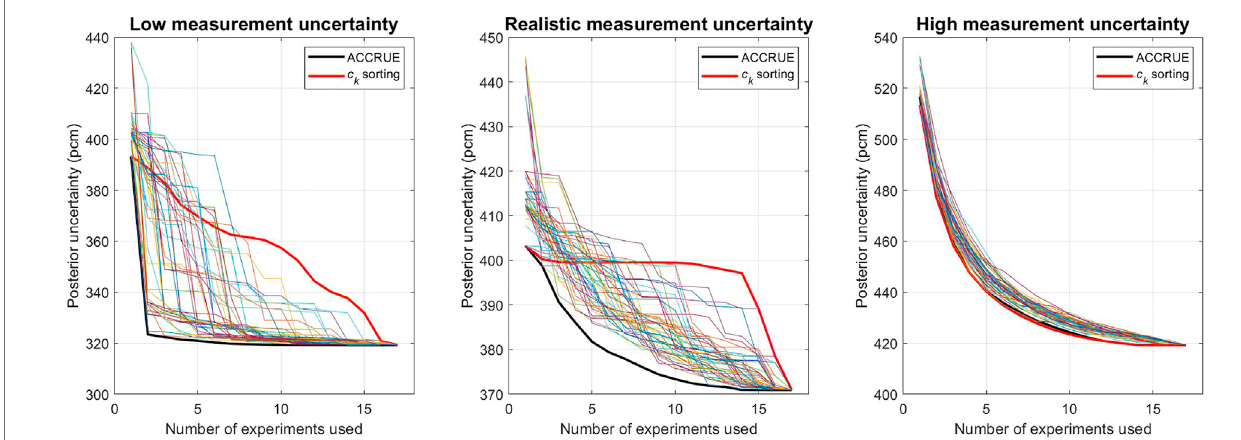
FIGURE 12 | Bias uncertainty reduction with random orders.